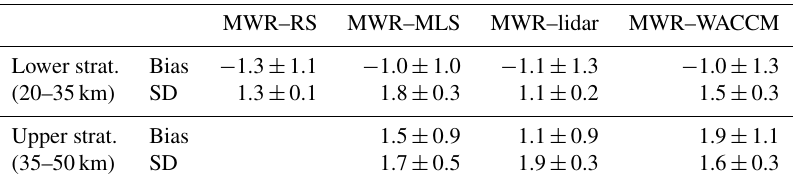
Table 1. Range of biases and standard deviations of the TEMPERA radiometer when compared with RS, MLS, lidar and WACCM measure- ments/model